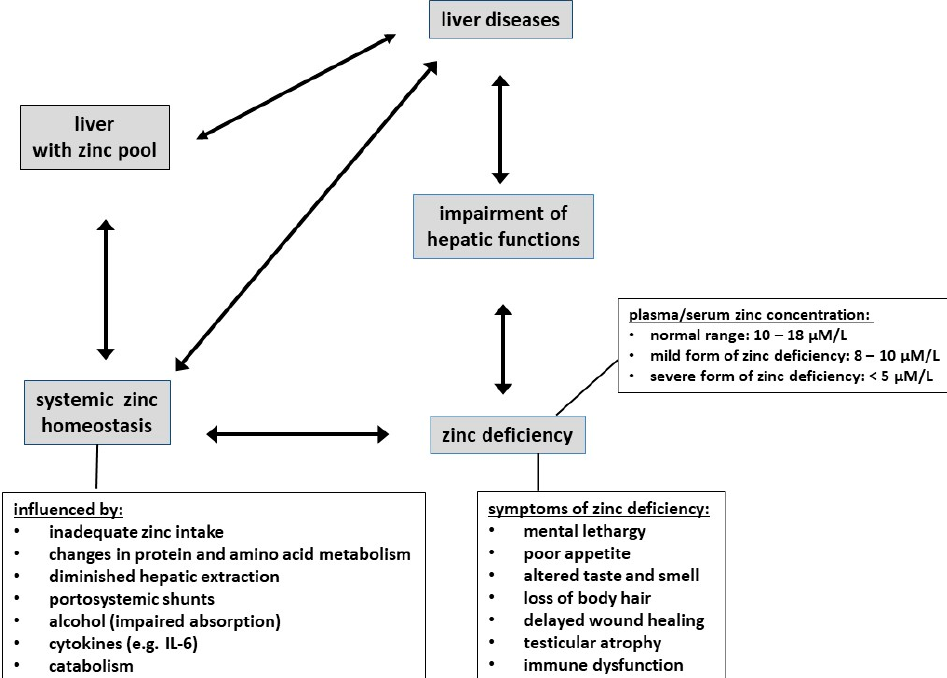
Figure 1. Schematic depiction of interactions between zinc homeostasis and the liver; factors influ- encing zinc in plasma/serum, symptoms of zinc deficiency and liver diseases.